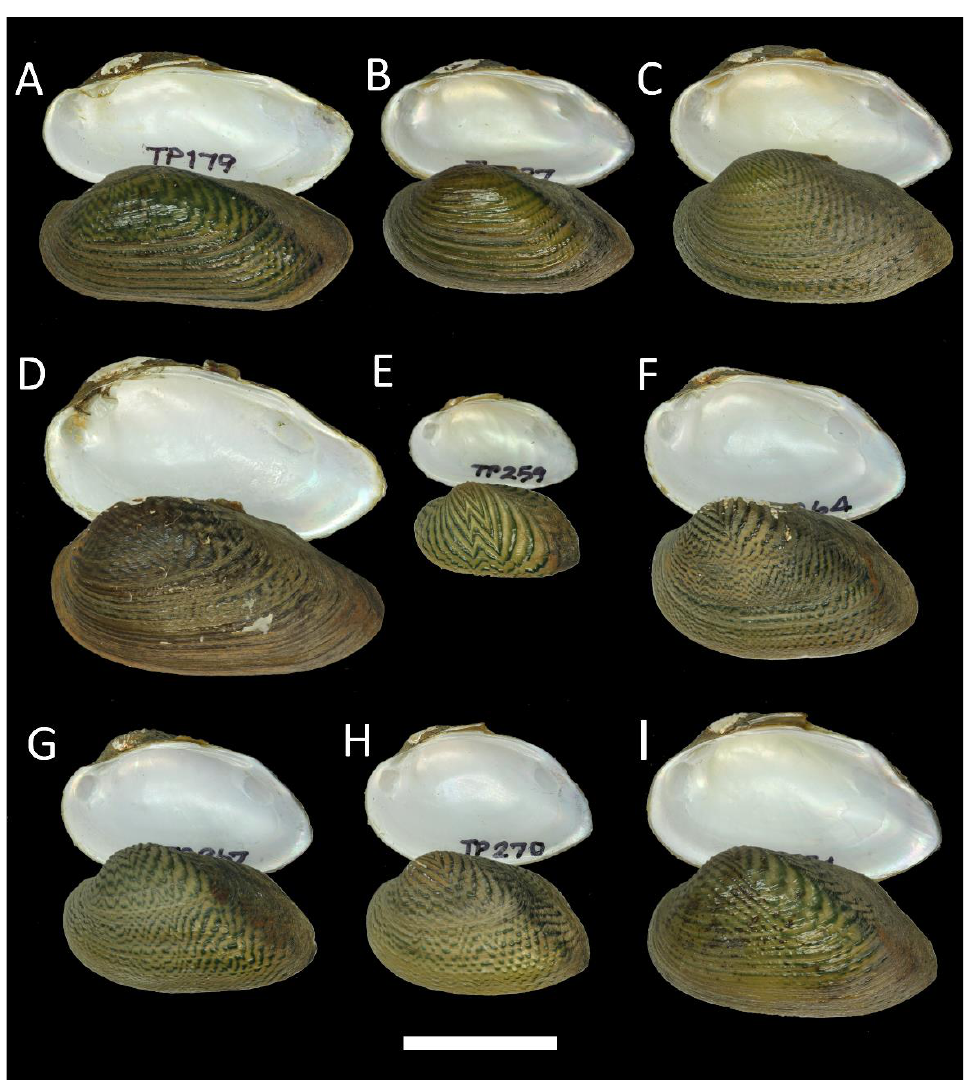
Figure 7. Shells of Scabies (Indochinellini) members from Southern Thailand. ( A ) Scabies phaselus (Lea, 1856), specimen RMBH biv 1288/1, Old main Tapi River, Surat Thani Province; ( B ) S. phaselus , specimen RMBH biv 1318/1, the same river; ( C ) S. phaselus , specimen RMBH biv 1318/9, the same river; ( D ) S. crispata (Gould, 1843), specimen RMBH biv 1287/1, Old main Tapi River, Surat Thani Province; ( E ) S. crispata , specimen RMBH biv 1312/1, Forest Park Lake, Surat Thani Province; ( F ) S. crispata (Gould, 1843), specimen RMBH biv 1313/1, the same lake; ( G ) S. crispata (Gould, 1843), specimen RMBH biv 1314, the same lake; ( H ) S. crispata (Gould, 1843), specimen RMBH biv 1315/1, the same lake; ( I ) S. crispata , specimen RMBH biv 1319/1, Old main Tapi River, Surat Thani Province. Scale bar = 20 mm. Photos: Ekaterina S. Konopleva.